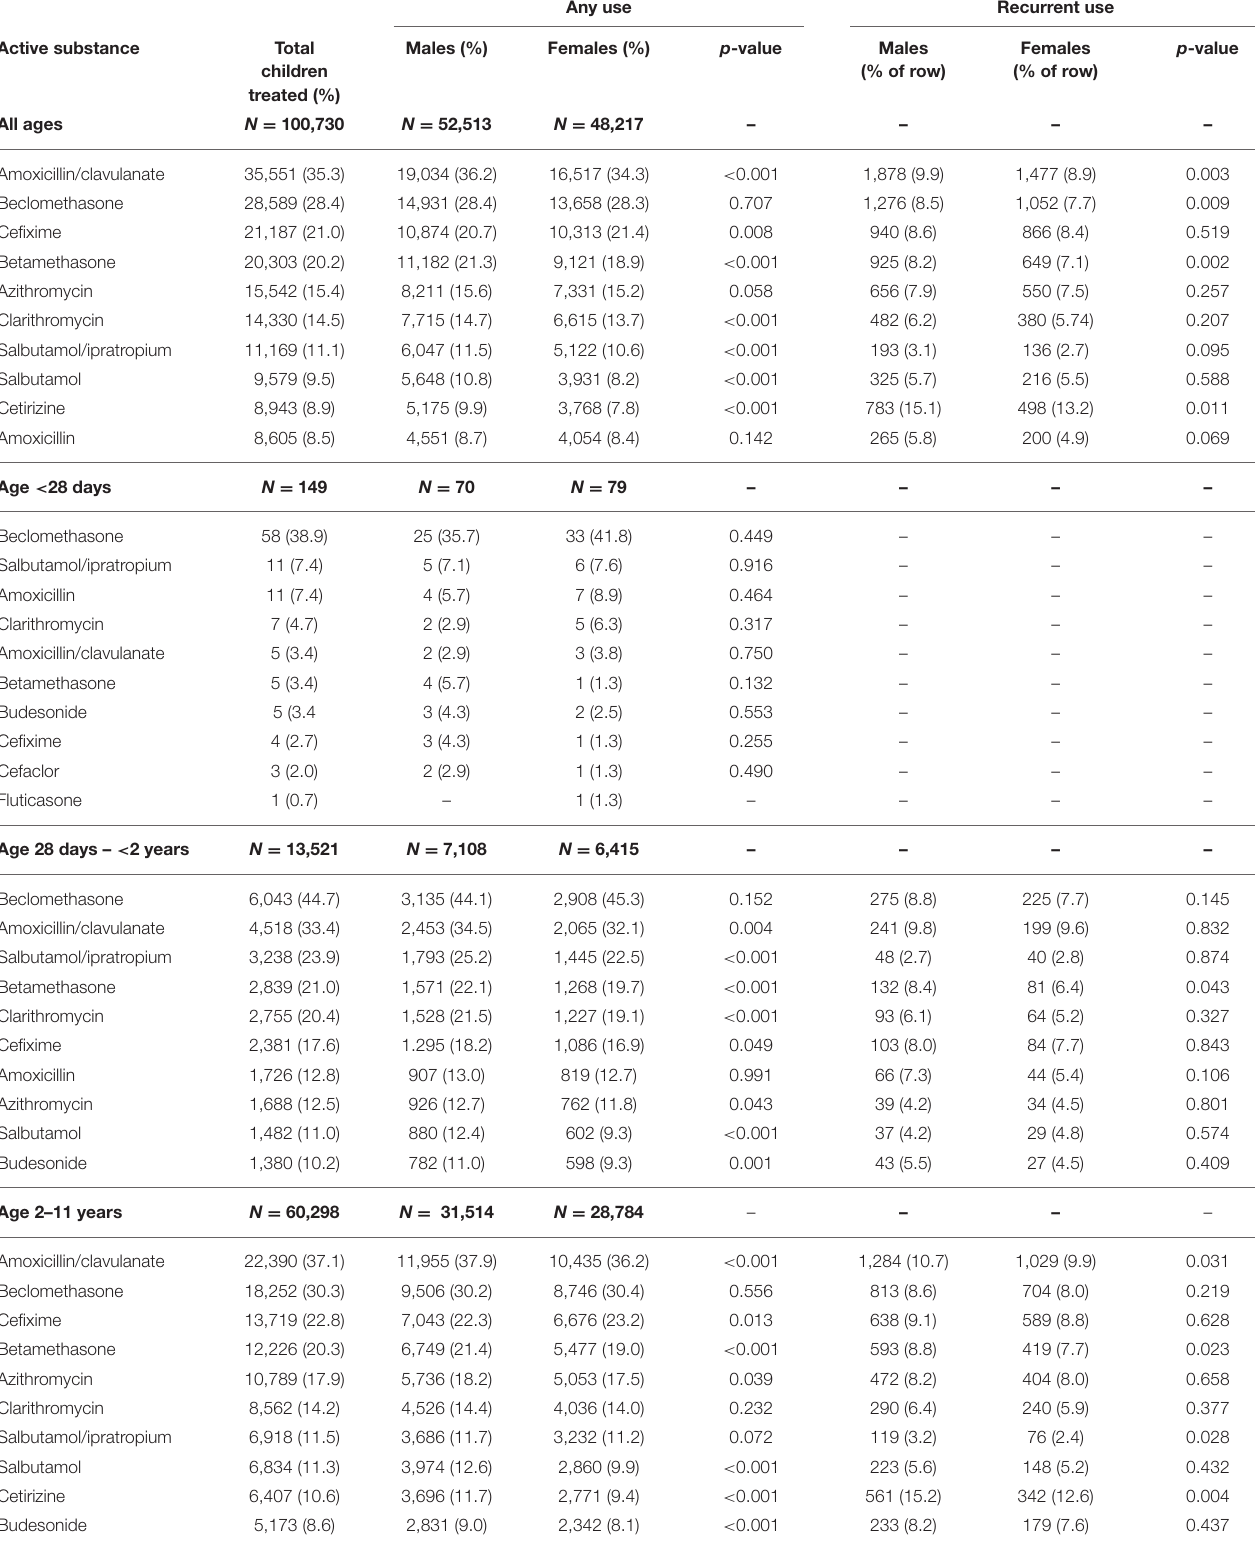
TABLE 2 | Distribution* of the 10 most frequently used drugs within each pediatric age group by gender in the year